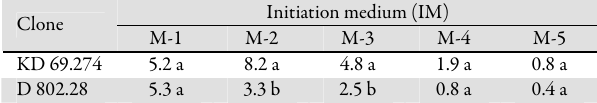
Table 1. Interaction effect of clone and media on the number of embryos per explant